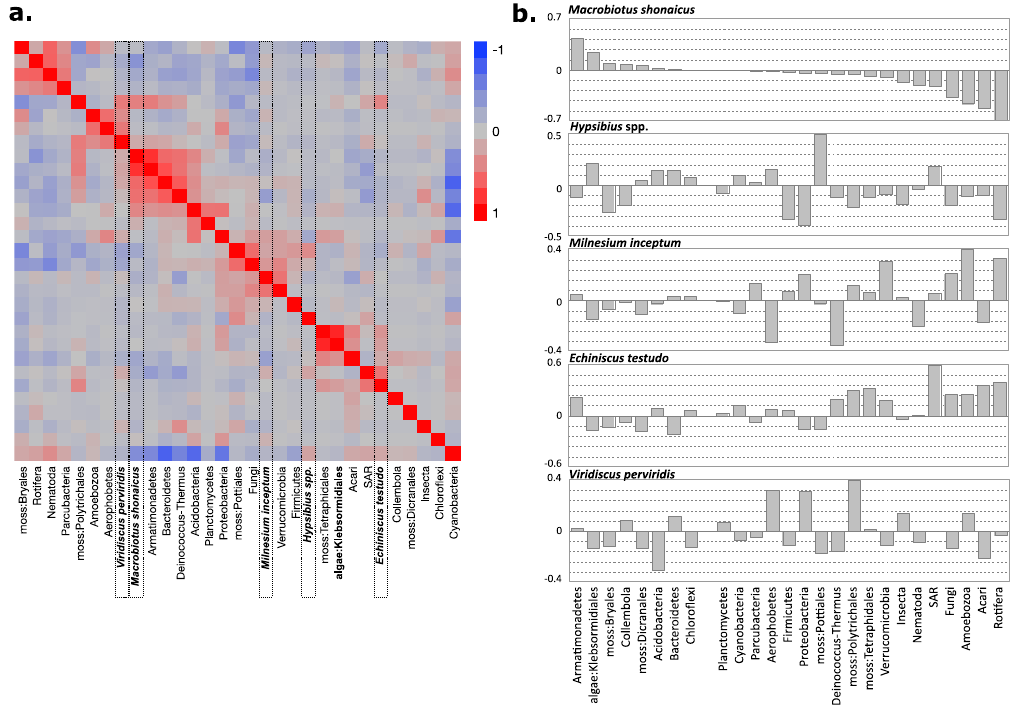
Figure 6. Correlations between species abundances within mesic samples. ( a ) Pearson correlation clustering of species abundances. Macrobiotus shonaicus is clustered with Armatimonadetes, Bacteroidetes, Deinococcus–Thermus, and Acidobacteria but is negatively correlated with Cyanobacteria and Rotifera. ( b ) Normalized coefficients for the partial least squares (PLS) model. Similar to the Pearson correlation, Armatimonadetes has the highest positive coefficient for M.